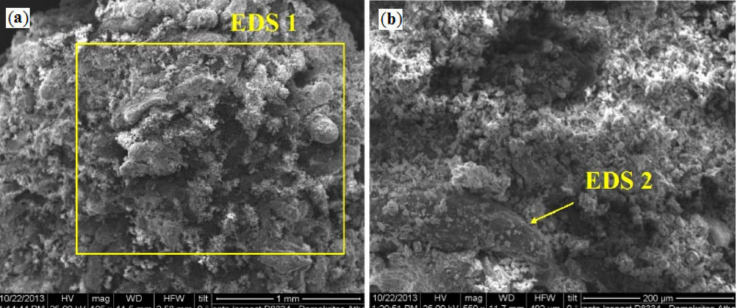
Figure 8. SEM images of the 24.1% NiO—55.9% Al—20.0% Al 2 O 3 catalyst after 900 ◦ C treatment: ( a ) sample with area indicated in the image (EDS 1) at 1 µ m scale; ( b ) sample with point (EDS 2) at 200 µ m